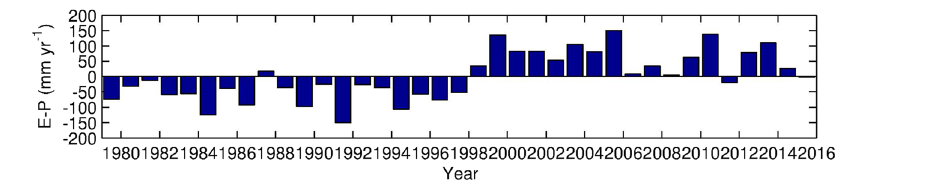
Figure 4. ERA-Interim annual mean surface freshwater flux (E-P in mm yr − 1 ) anomaly (relative to 1979–2013) for the south-eastern Mediterranean box shown in Fig.